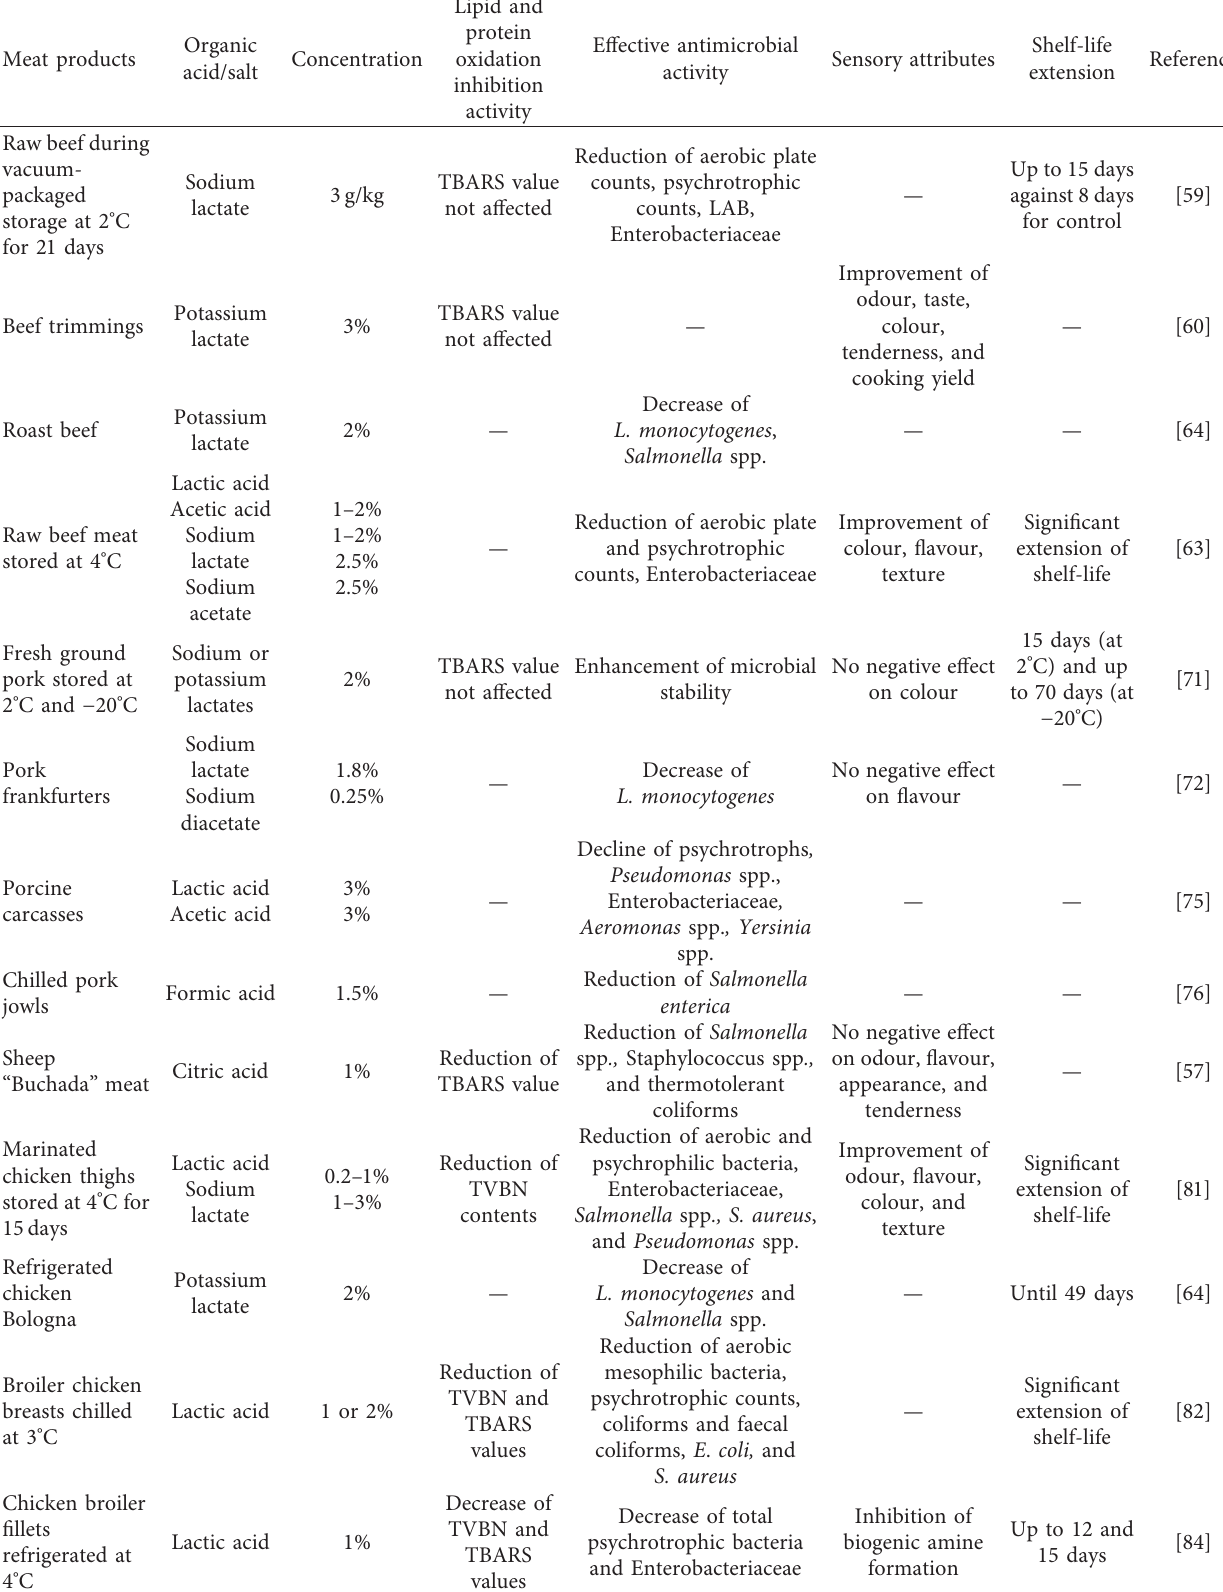
Table 5: Applications of organic acid and their salts in meat